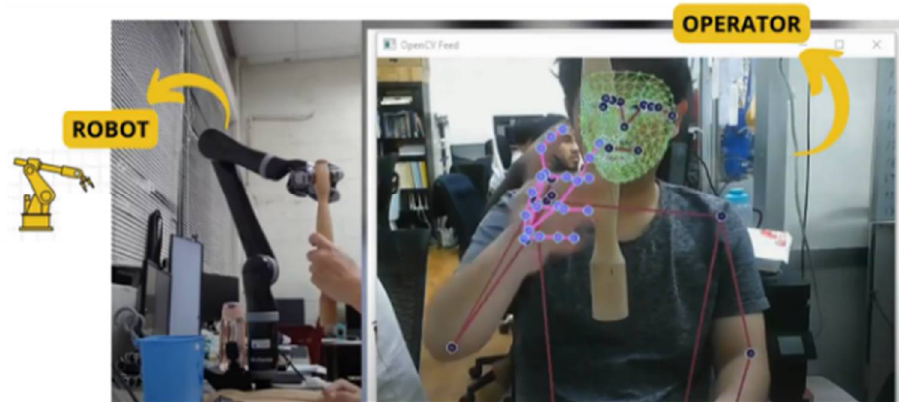
Figure 13. Collaboration Activity.